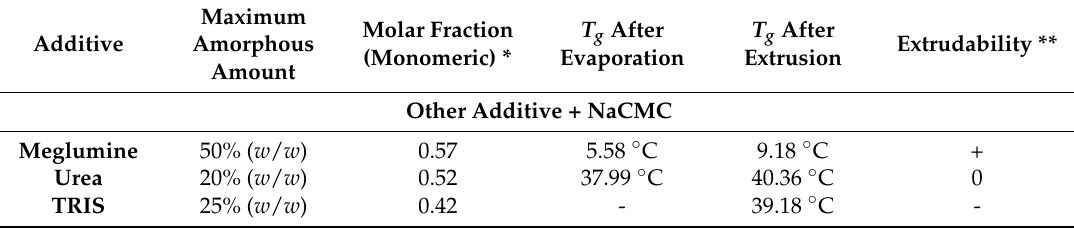
Table 2. Properties of the other additive polyelectrolyte